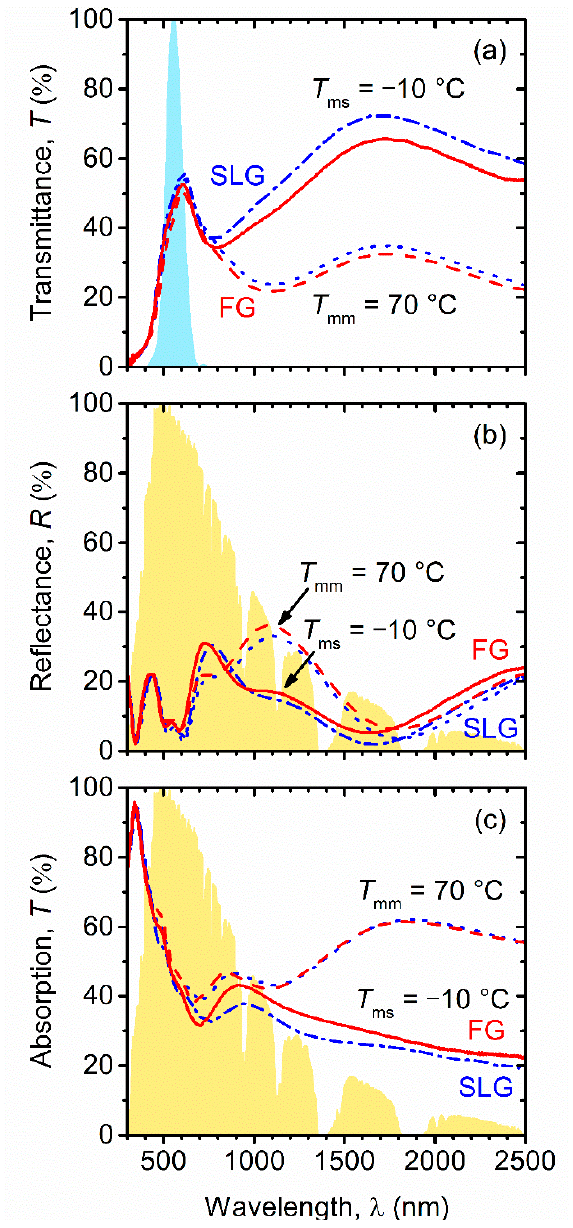
Figure 6. Spectral transmittance ( T ), reflectance ( R ) and absorption ( A ) at an angle of incidence of 7° for the ZrO 2 /V 0.984 W 0.016 O 2 /ZrO 2 coatings on 0.1 mm thick FG (solid and dashed lines) and 1 mm thick SLG (dash-dotted and dotted lines) substrates at T ms = − 10 °C (significantly below T tr = 22 °C) and T mm = 70 °C (significantly above T tr = 22 °C). The boundaries of the shaded areas represent the luminous sensitivity of the human eye ( φ lum ) in panel ( a ), and the sea-level solar irradiance spectrum ( φ sol ) at an air mass of 1.5 in panels ( b , c ), normalized to maxima of 100%.